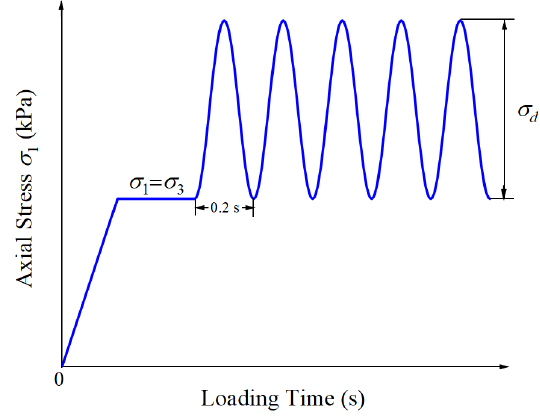
Figure 4. The time–history curve of the axial